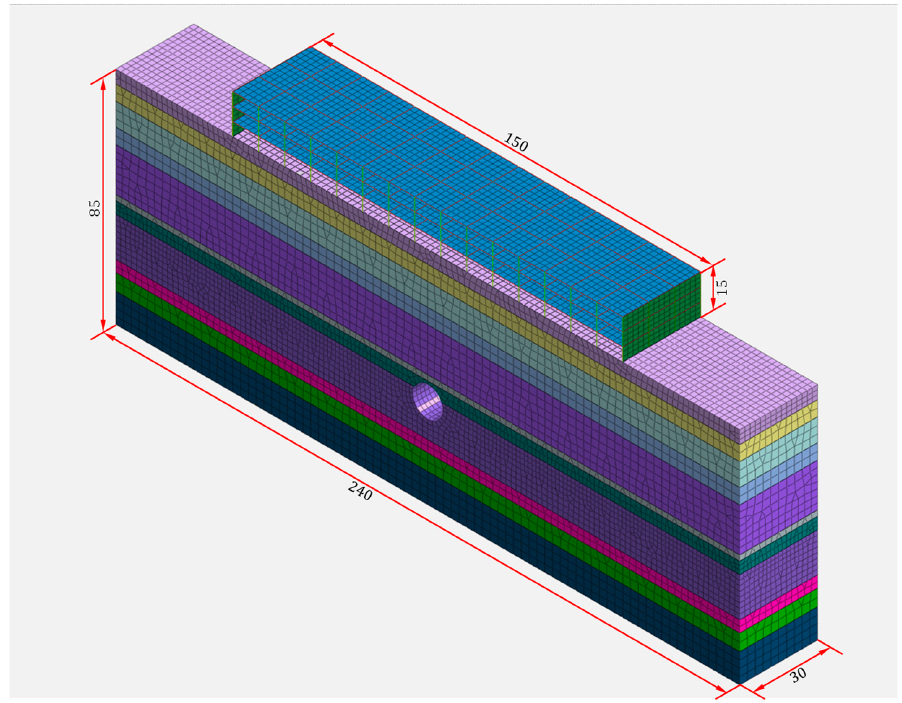
Figure 2. Finite-element model of the superstructure-underground-tunnel system (Unit: m).